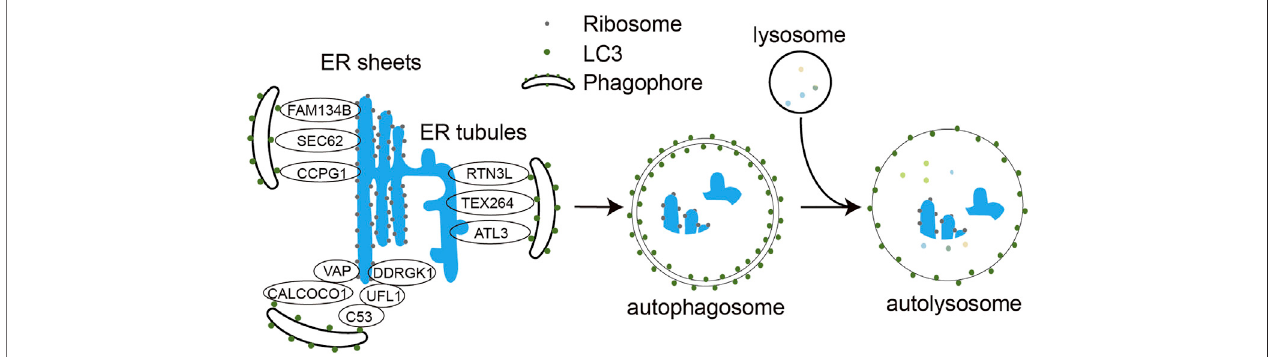
FIGURE 1| Molecular mechanism ofER-phagy. Under different stress conditions, ER-phagy receptors FAM134B, SEC62, RTN3L, ATL3, TEX264, CCPG1, C53, and CALCOCO1 bind to LC3 via their LIR motifs and engulf ER structures in need of degradation into the phagocytic vesicles, which subsequently expand and close to form double-membrane autophagosomes. The autophagosome further fuses with the lysosome to form autophagolysosome. The encapsulated ER fragments are eventually degraded by hydrolases in the